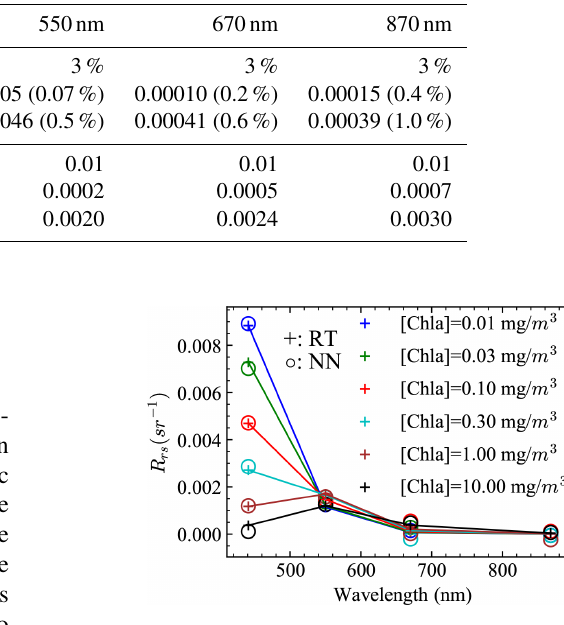
Figure 5. Comparison of the truth R rs (RT) and the neural network (NN) computed R rs . The truth R rs is computed from radiative trans- fer simulations with a zenith sun and nadir viewing direction. The NN computed R rs follows Eq.